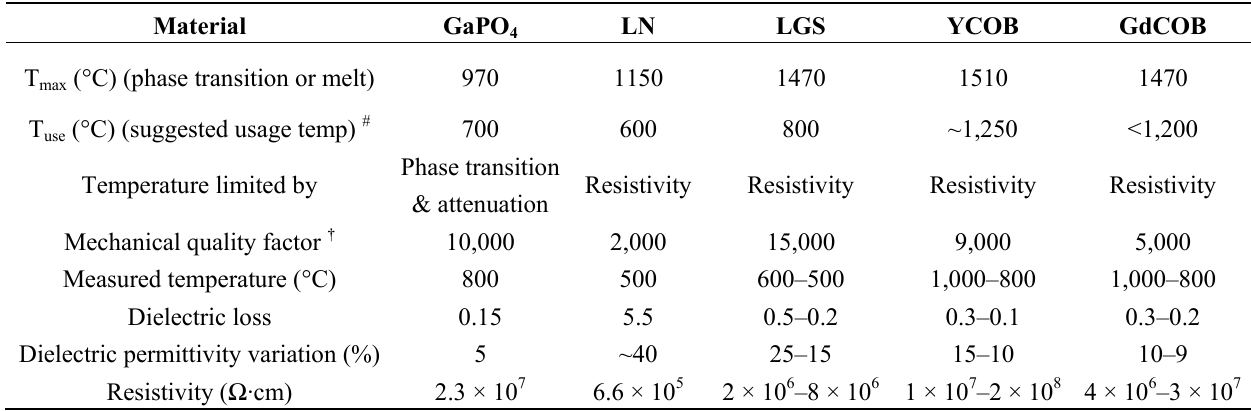
Table 2. High-temperature piezoelectric materials